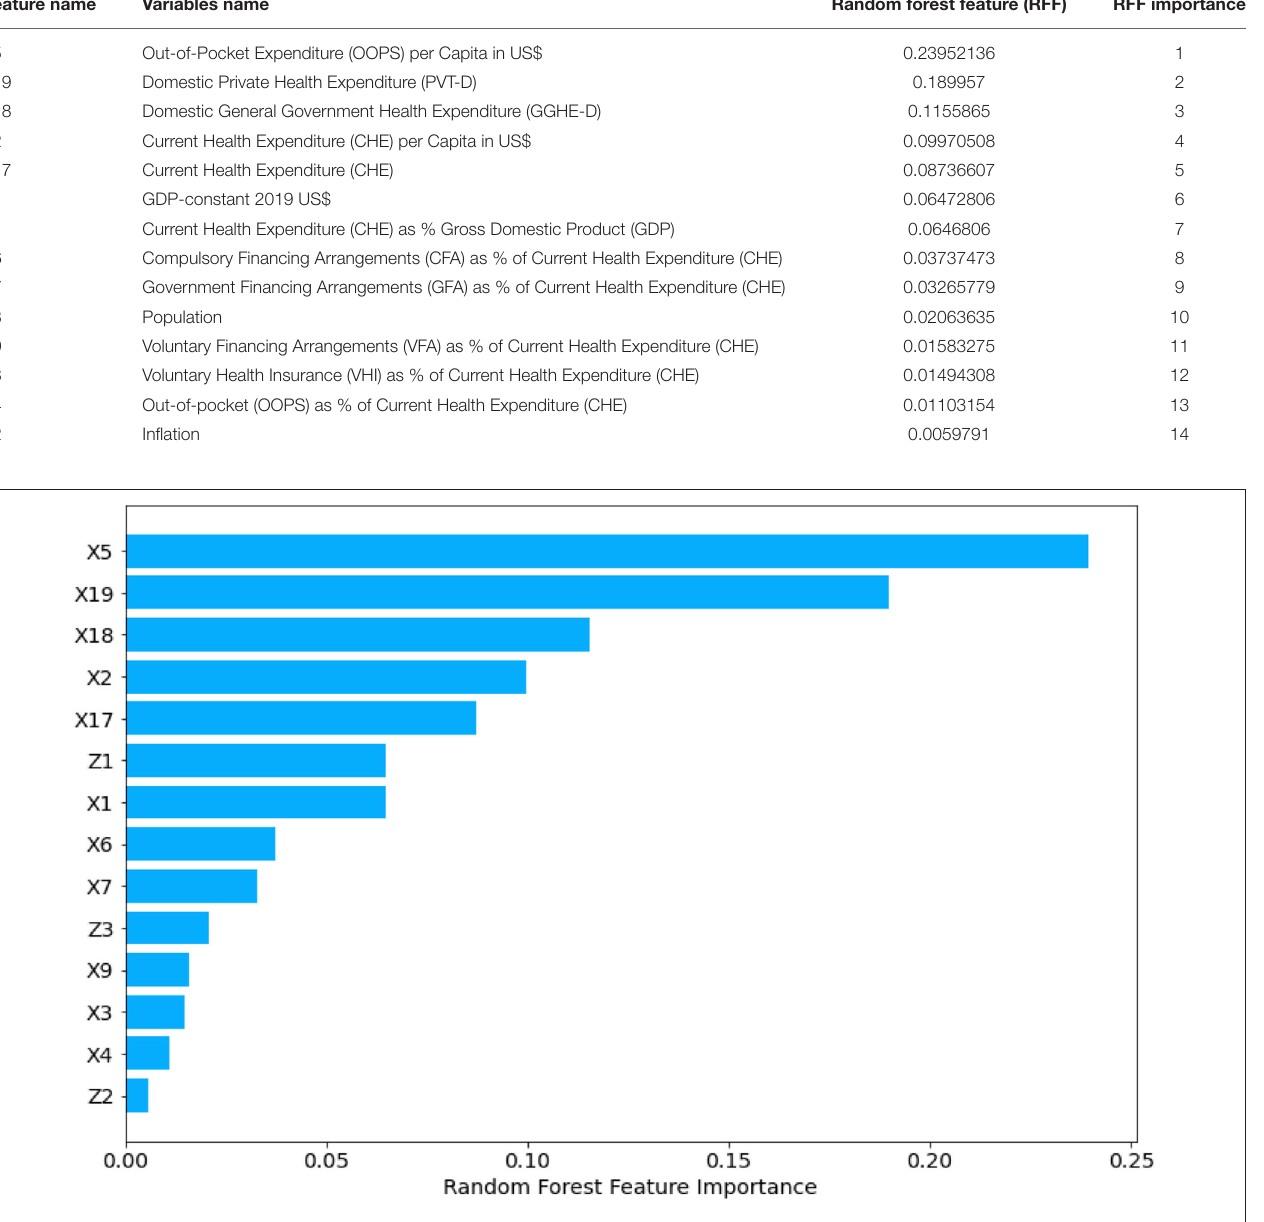
FIGURE 2 | Random Forest feature importance in UHC for all three economic